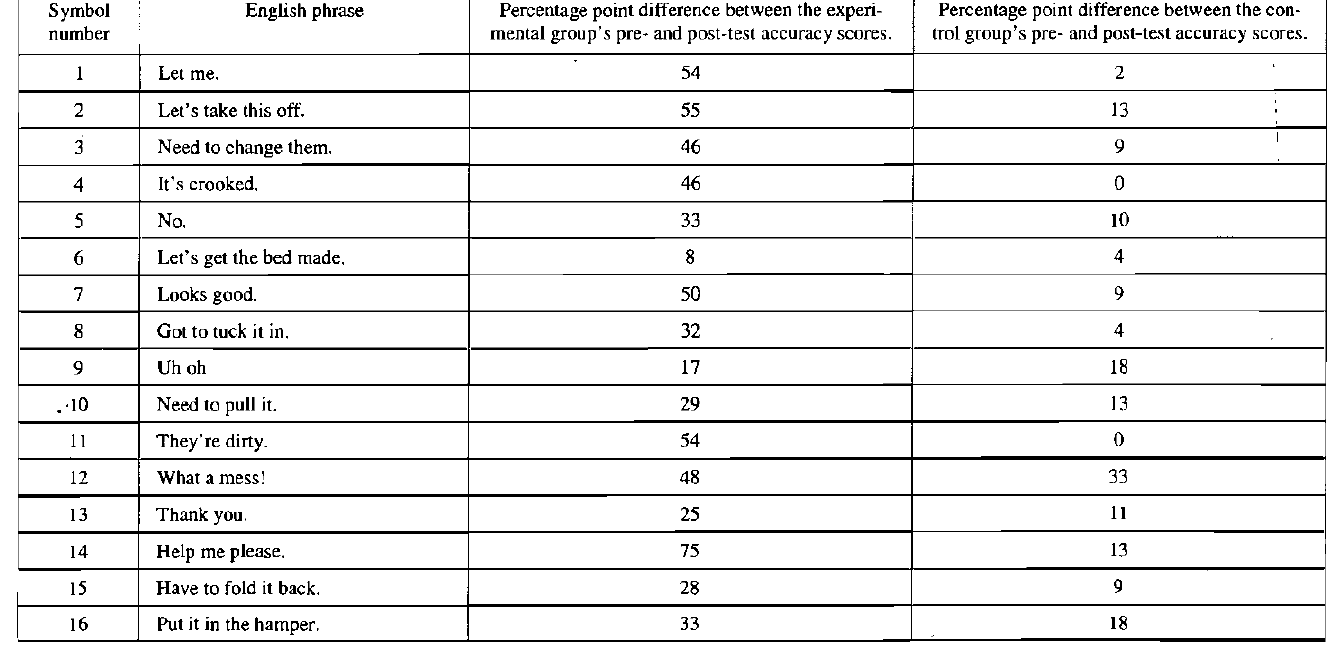
Die Suid-Afrikaanse Tydskrifvir